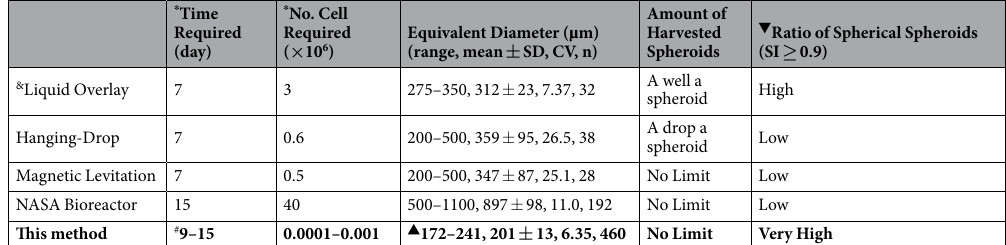
4A π π SI , where A P